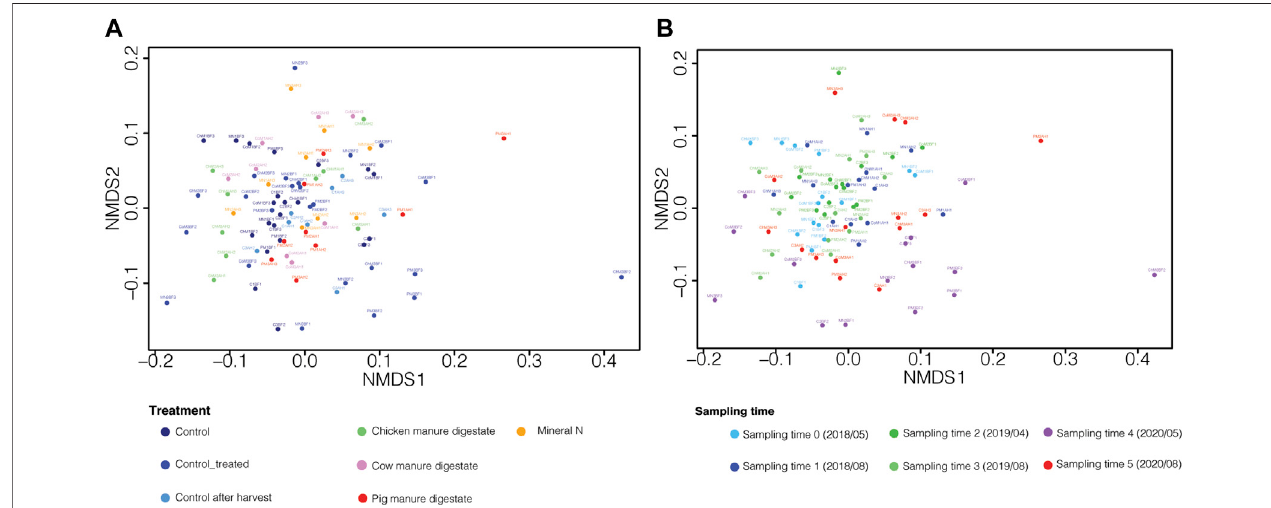
FIGURE 2 | Non-metric multidimensional scaling (nMDS) plot. nMDS plot based on the Bray – Curtis index. (A) nMDS plot with samples colored with respect to the treatment used: control (before fertilization, no fertilization), control-treated (before fertilization, fertilized the precedent year), control after harvest (after harvest, no fertilization), mineral nitrogen (after harvest), chicken manure digestate (after harvest), cow manure digestate (after harvest), and pig manure digestate (after harvest). (B) nMDS plot with samples colored with respect to sampling time.